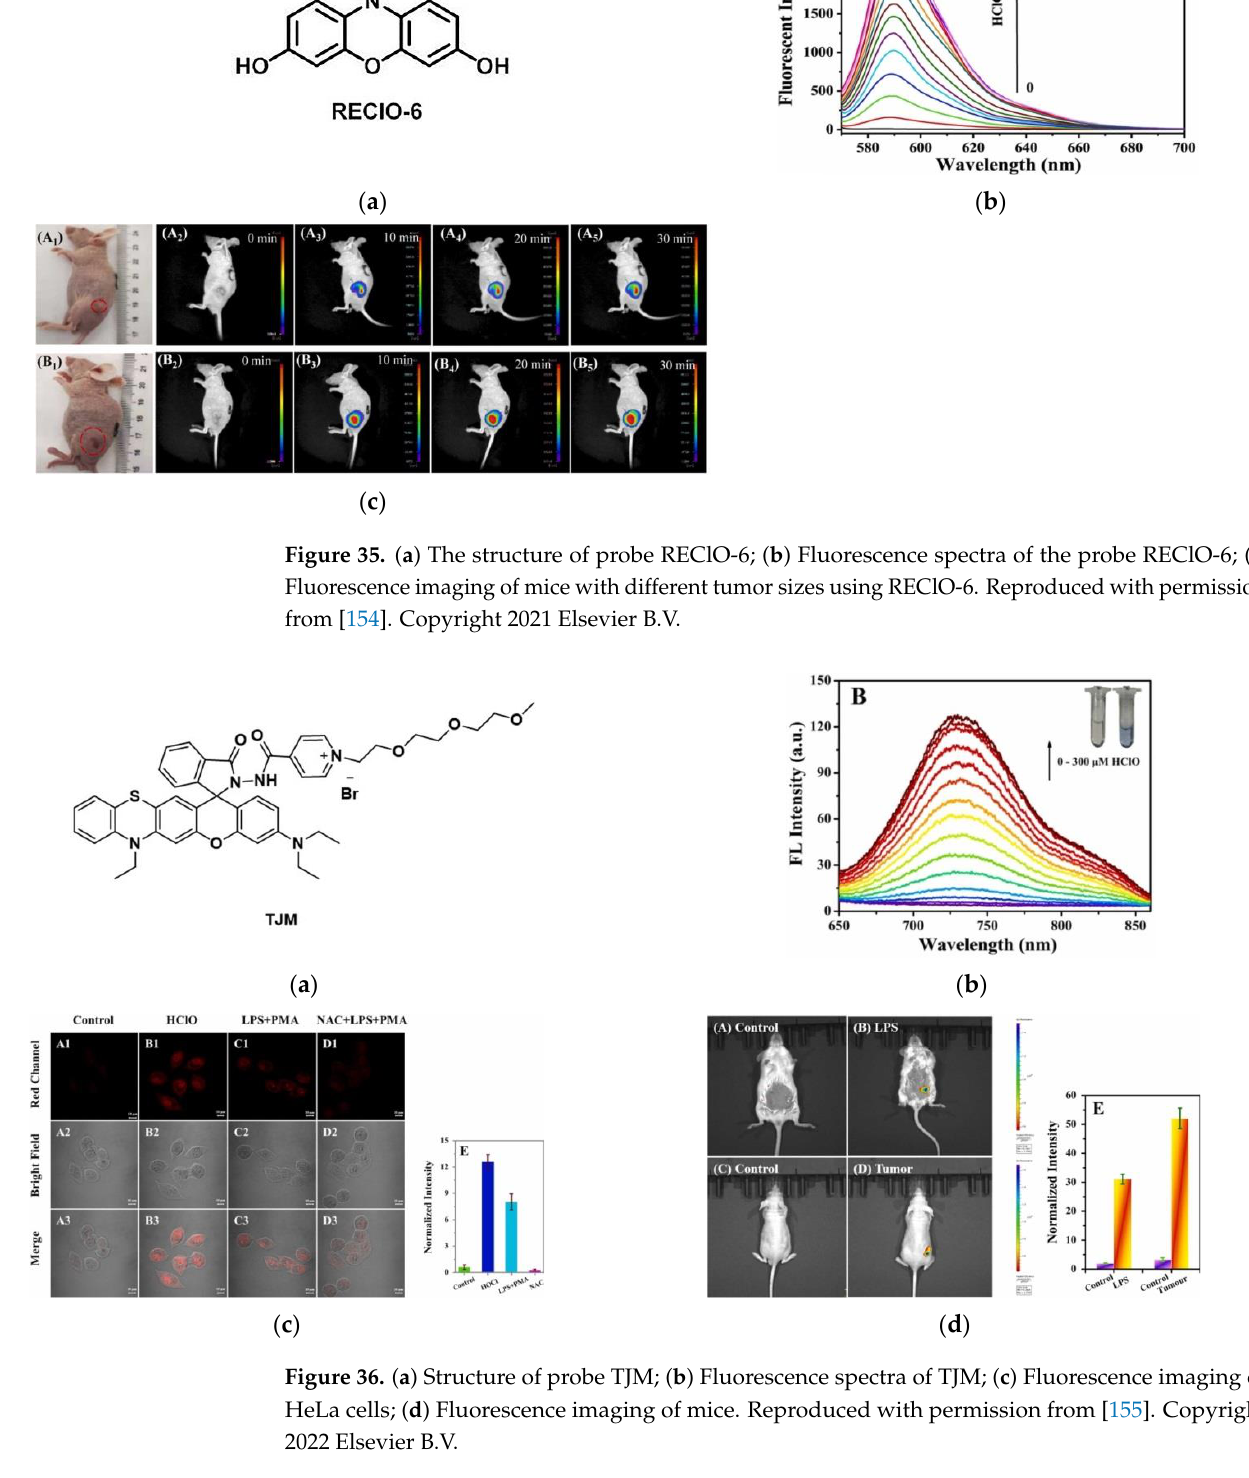
( b ) Figure 37. ( a ) The structure of probe BA-Resa; ( b ) Microscopic images of probe RA-Resa in live OSCC cells. Reproduced with permission from [167]. Copyright 2016 American Chemical Society. Again in 2016, K o ̈ nig et al. [168] designed a novel fluorescent probe 1 (Figure 38a). In Figure 38b, the probe bound to NAD(P)H, resulting in a clear increase in fluorescence intensity at 561 nm. In cell experiments, HEK-293 cell lines were selected, and the results confirmed that the probe has low cytotoxicity and can be applied to the detection of NAD(P)H in mammalian cells. Imaging in the tumor spheroid model (Figure 38c) showed that the probe responded significantly to the fluctuation of NAD(P)H in tumor cells.